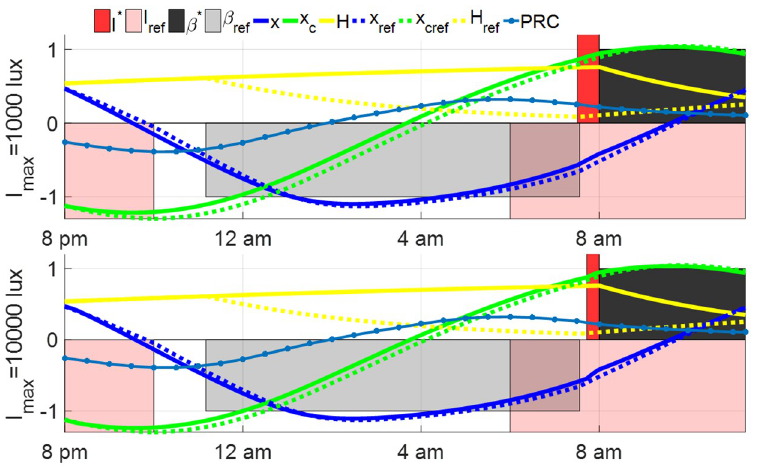
Fig 18. Minimum-time entrainment with optimal light input during the night shift from 8 pm to 8 am with I max = 1000 lux (upper) and I max = 10000 lux (lower). The entrainment time of these two cases is both 3.28 hours (12 hours night shift is excluded from the entrainment